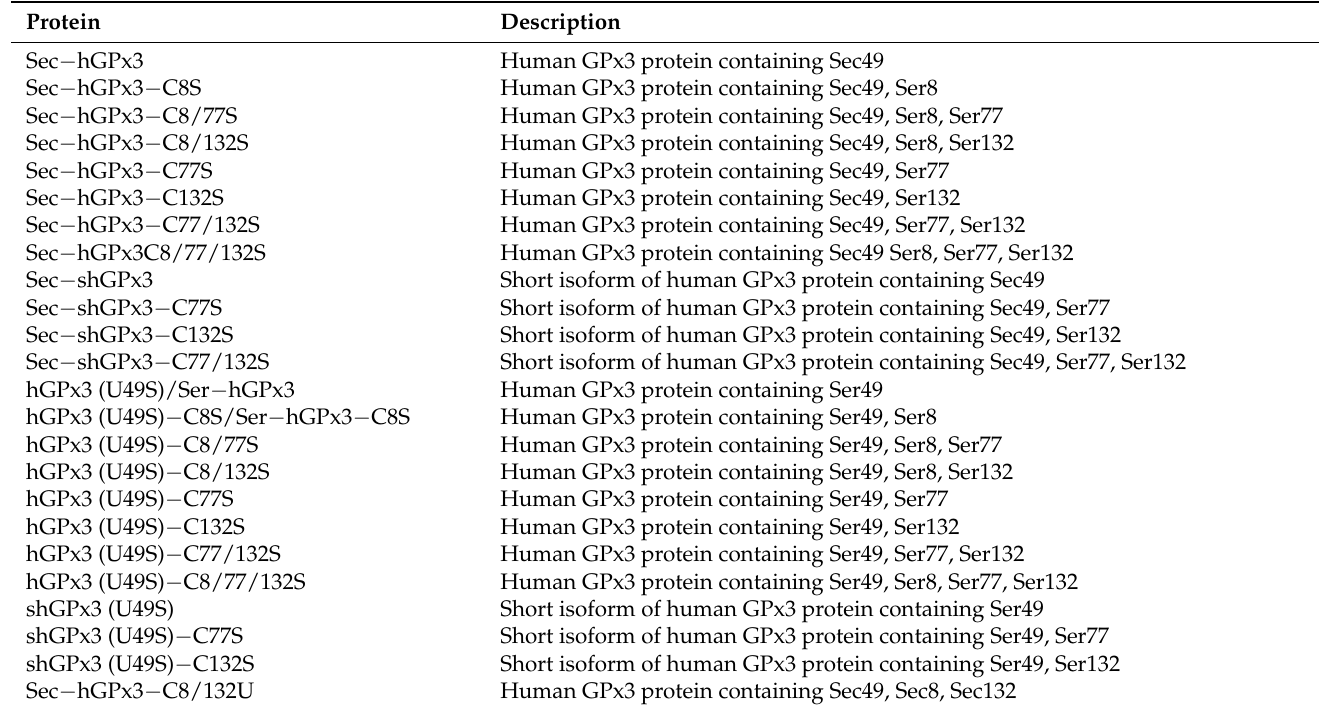
Table 2. Description of various mutant proteins in this